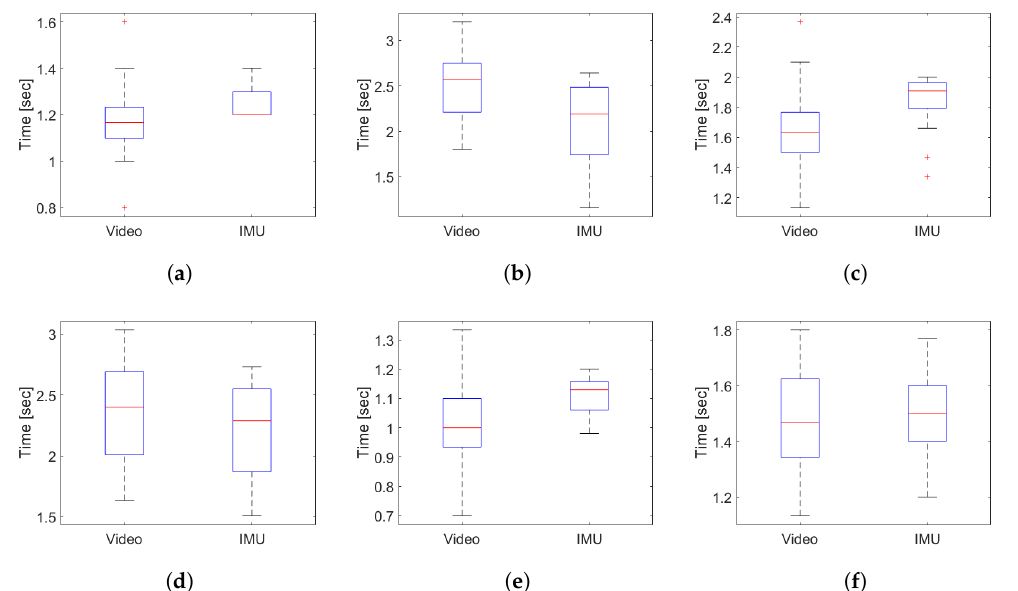
Figure 18. Distribution plots of the duration times obtained with the segmentation algorithm compared with the video analysis in the young subjects. ( a ) duration distribution for standing time; ( b ) duration distribution for the first walk time; ( c ) duration distribution for the 3-m turning; ( d ) duration distribution for the second walk time; ( e ) duration distribution for the pre-sitting turning time; ( f ) duration distribution for sitting